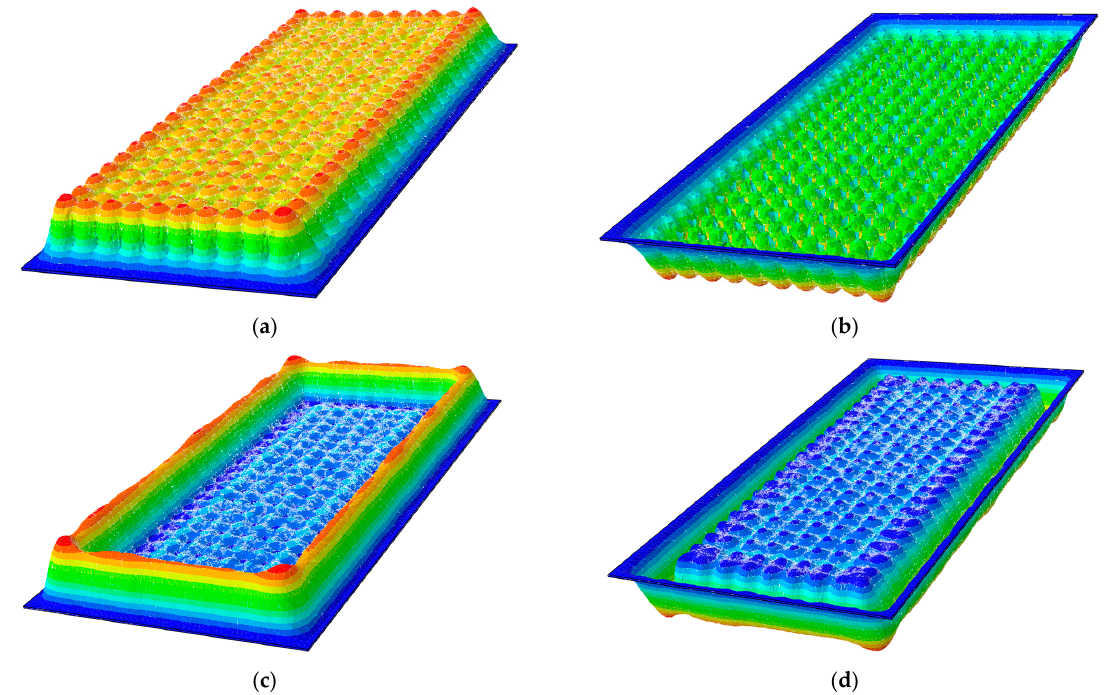
Figure 10. Shapes of the ( a ) bottom and ( b ) top glass panes deformations for x 0 = y 0 = 50 mm as well as ( c ) bottom and ( d ) top glass panes for x 0 = y 0 = 100